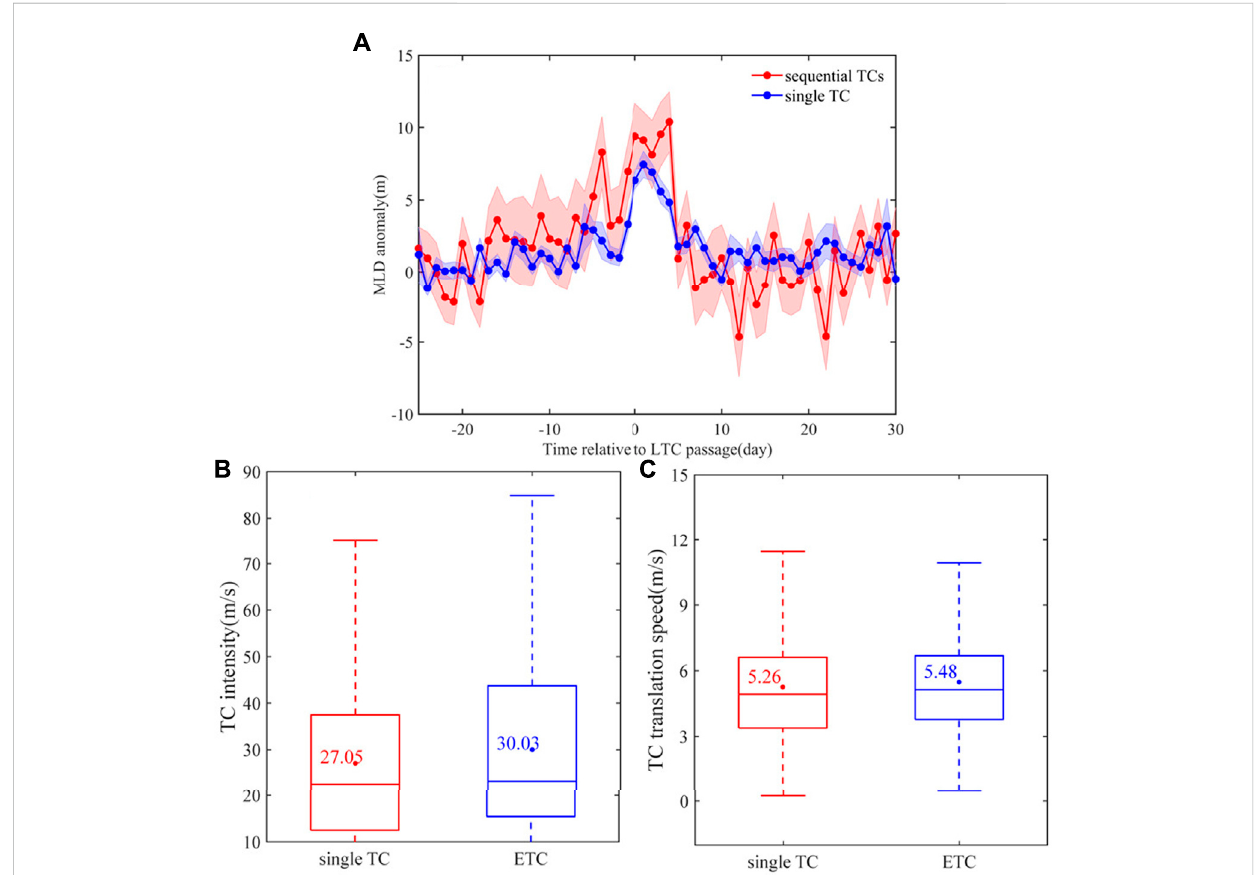
FIGURE 6 The mixed layer depth (A) as a function of days relative to the LTC passage. The shaded areas show the standard errors of the mixed layer depth. Boxplotsoftheintensity (B) andtranslationspeed (C) forthesingleTCETC.ThestrongerTCintensityforthe,ETC.,thanthatforthesingleTCissigni fi cant above the 95% con fi dence level based on Student ’ s t-test. The differences between the, ETC., and the single TC in translation speed are insigni fi cant based on the Student ’ s t-test.